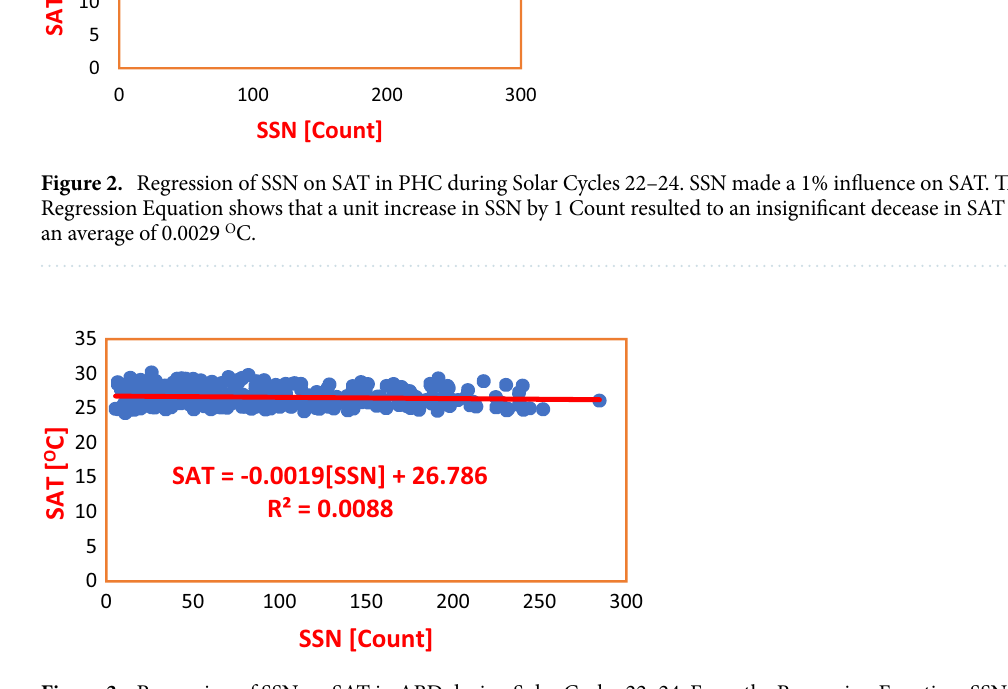
Figure 3. Regression of SSN on SAT in ABD during Solar Cycles 22–24. From the Regression Equation, SSN accounts for a negligible decrease in SAT by a mere 0.0019 °C. R 2 value indicates that the impact of SSN on SAT is 0.8%, which is ‘too small’ to effect variation in